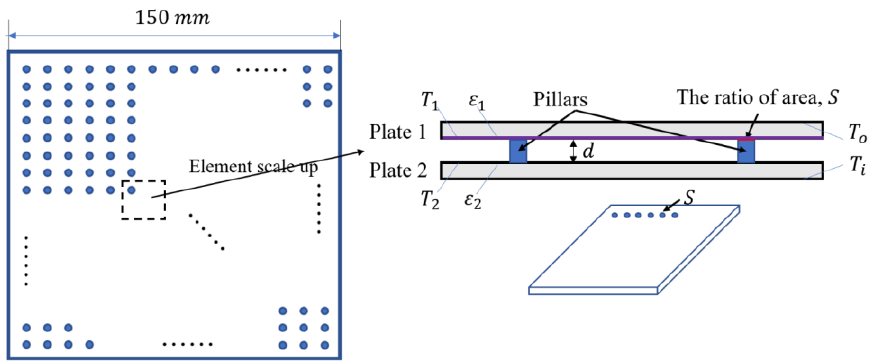
Figure A1. One-dimensional calculation model of VIP.